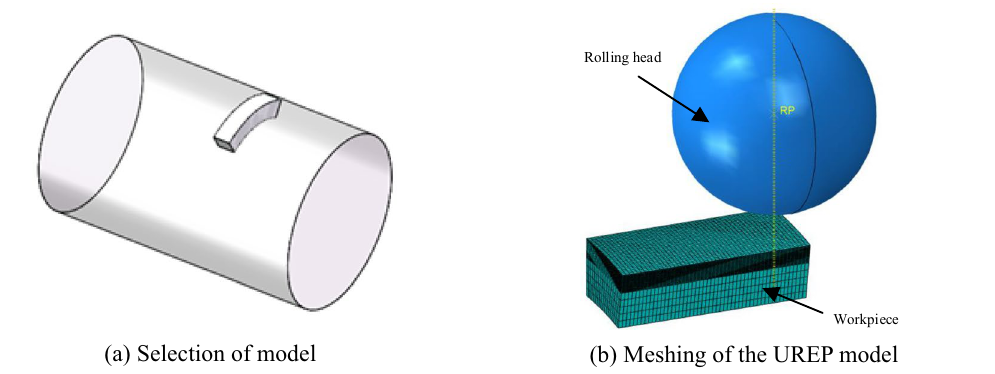
Figure 5. Establishment of UREP